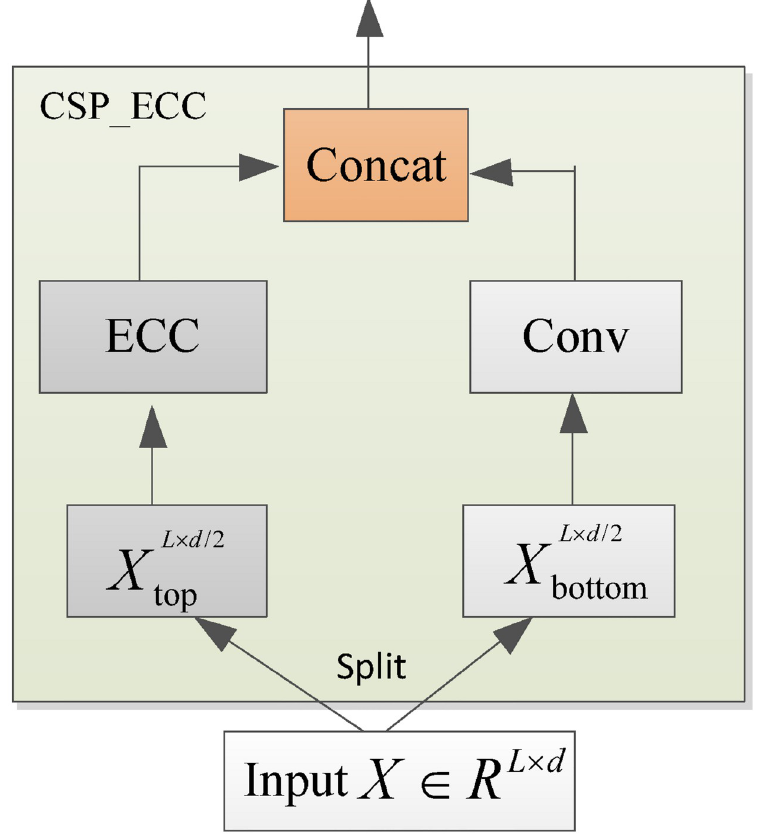
Fig 2. The structure of the CSP_ECC.